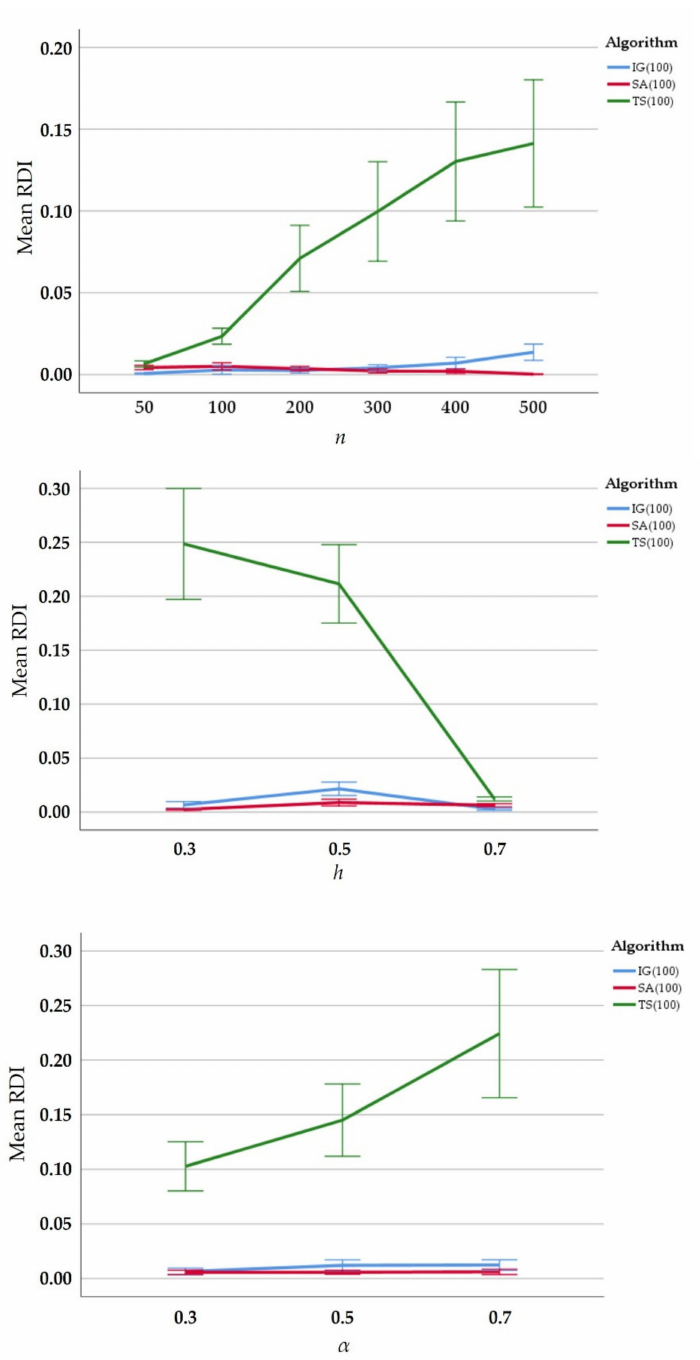
Figure 6. Mean plots for interaction between algorithms and problem